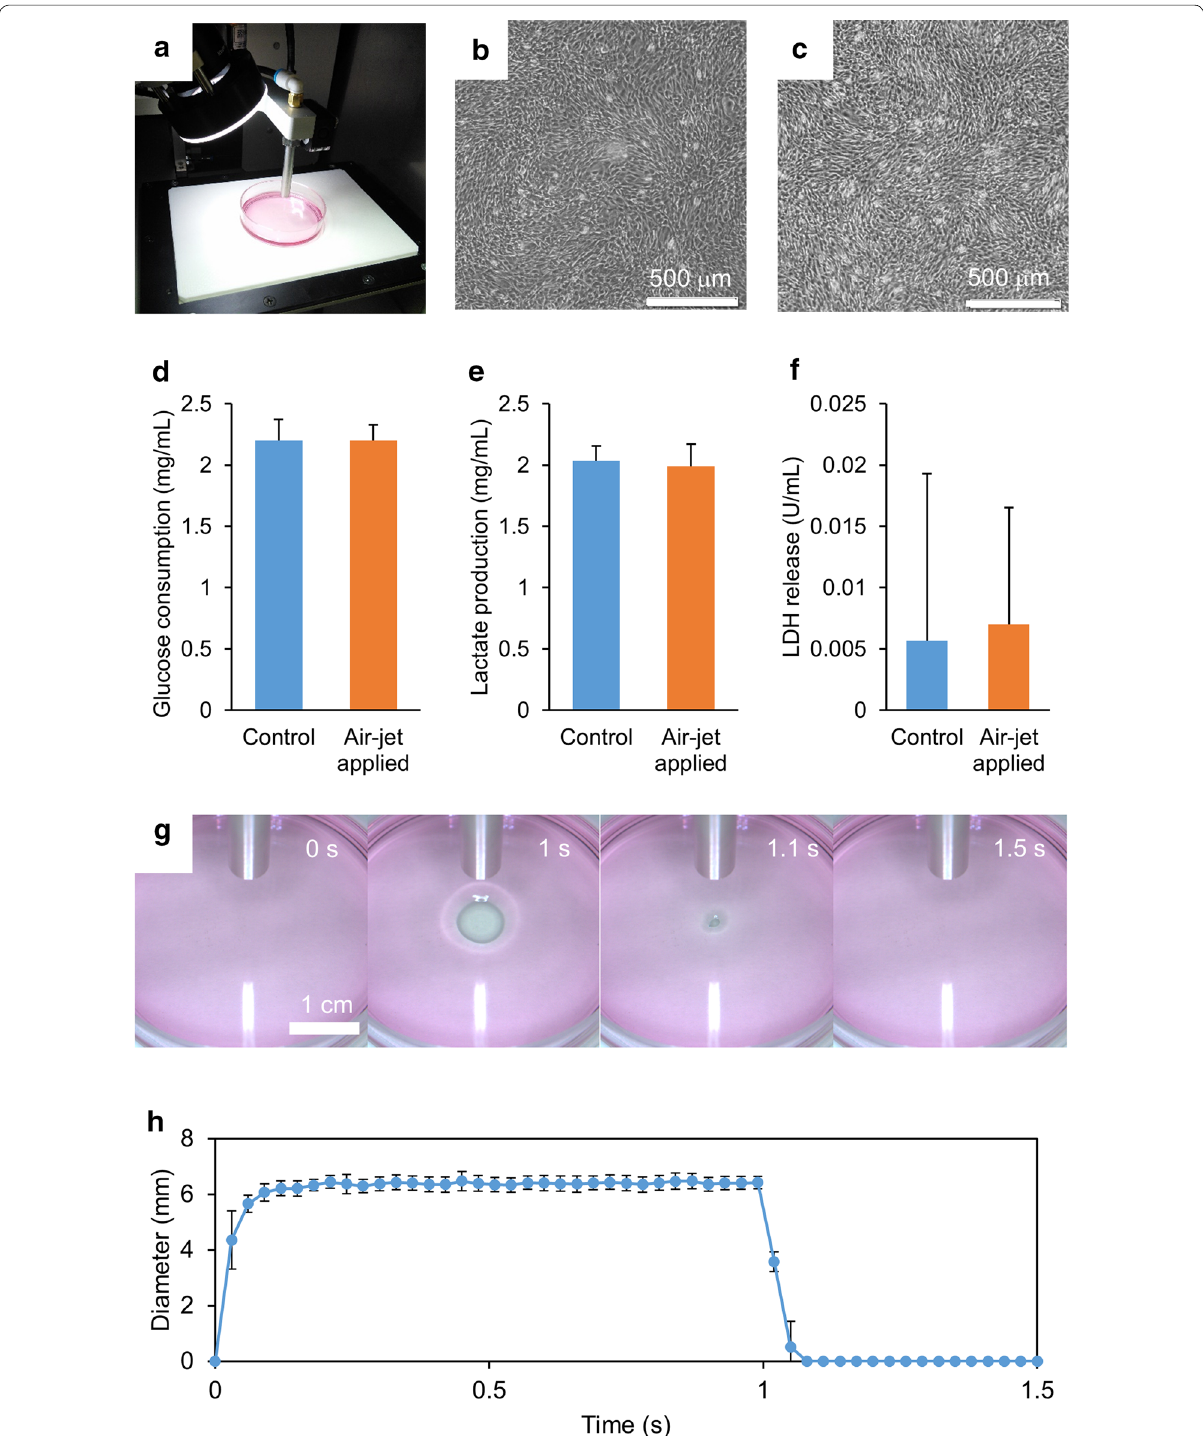
Fig. 6 Influence on cultivated cells during non-contact wettability assessment. a Photo showing part of the experimental set-up. Microphoto- graphs b , c show the surfaces of cultivated cells before and after 10-kPa-pressure air-jet application, respectively. Graphs d – f show the glucose consumption, lactate production, and lactate dehydrogenase release of the culture system during a 1-day culturing after noncontact wettability assessment, respectively. Bars and error bars indicate average values and standard deviations (n showing culture medium during non-contact wettability assessment (see also Additional file 4: Movie 2). Graph h shows the time-course of the liquid-squeezed diameter. Data points and error bars indicate mean values and standard deviations (n